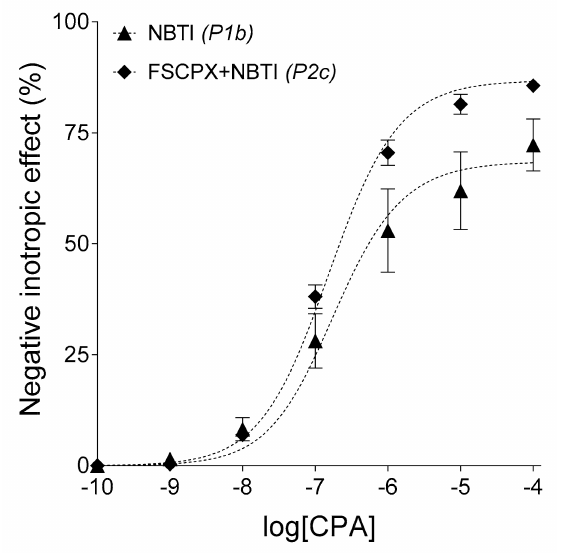
Figure 3. The direct negative inotropic effect of CPA in the presence of NBTI, without and with a previous FSCPX pre-treatment. The applied (pre)treatments and experimental groups ( latter ones in italics ) are indicated. The x -axis denotes the common logarithm of the molar CPA concentration (in the bathing medium) and the y -axis indicates the effect (as a percentage decrease in the initial contractile force). The symbols show the responses to CPA